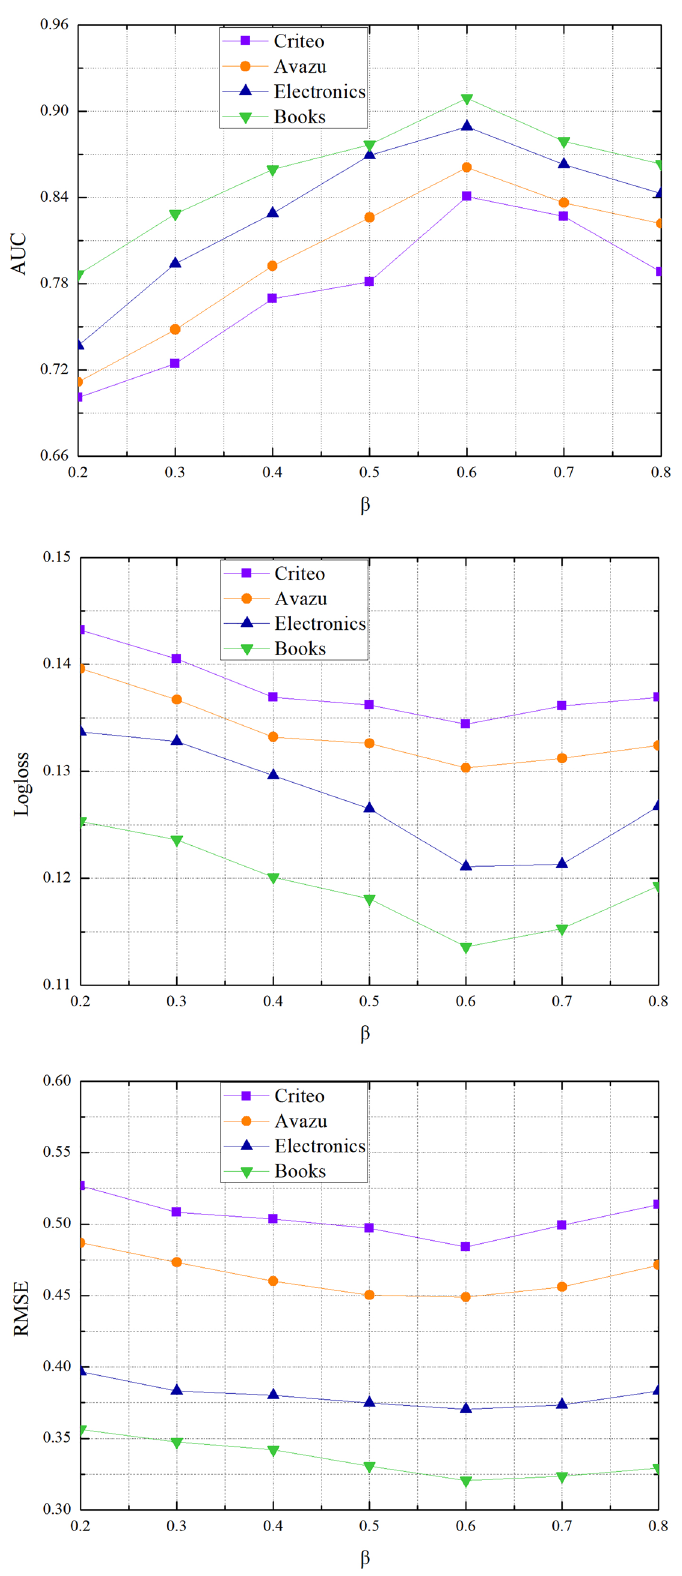
Figure 4. Performance comparisons w.r.t. the dropout rate β